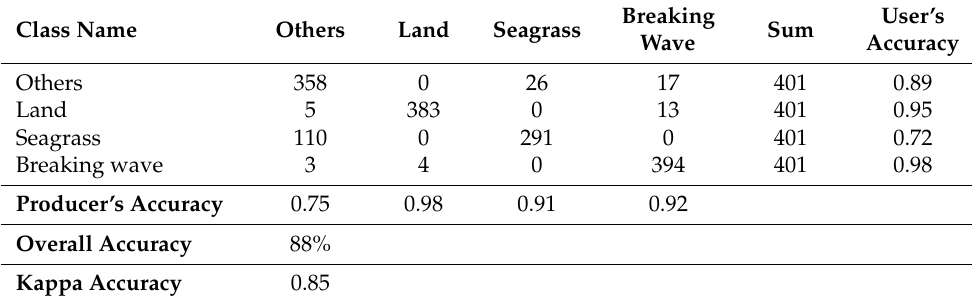
Table 5. Confusion matrix for seagrass classification using Sentinel-2.